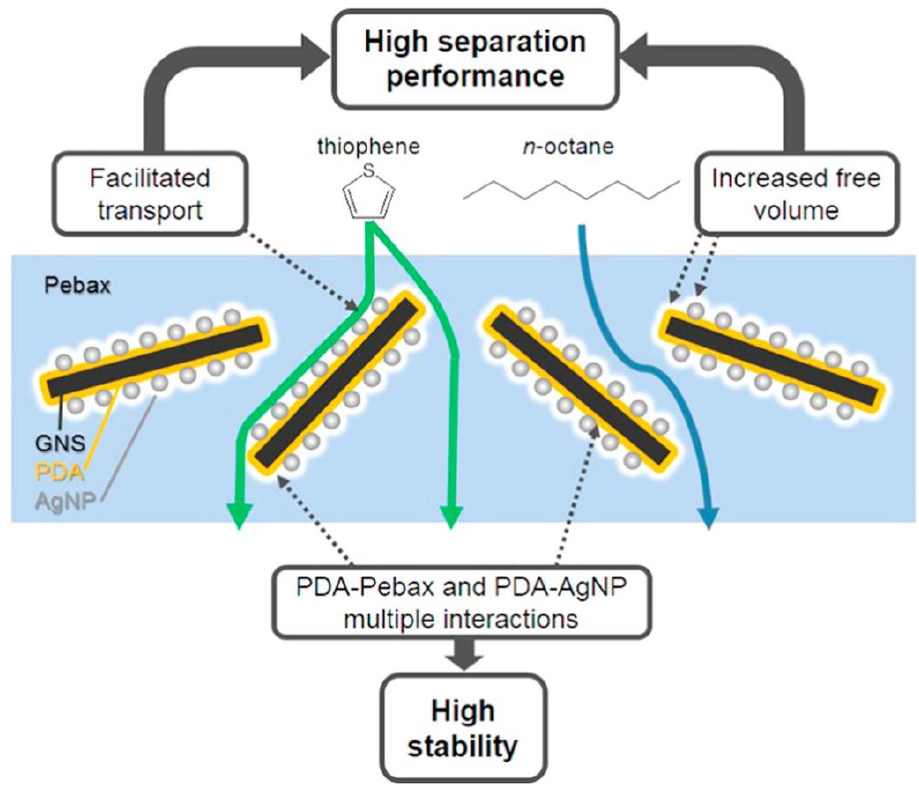
Figure 4. Scheme of an MMM comprising graphene nanosheets (GNS) functionalized by polydopamine (PDA) coating and then loaded with silver nanoparticles (AgNP) (from ref. [35]). Graphene oxide (GO) is usually synthesised by chemical oxidation and exfoliation of graphite, (e.g., via the Hummers method) [85]. Contrary to graphene, GO is highly hydrophilic since the oxidation generates several oxygen-containing groups (hydroxyl, epoxide and carboxylic groups) on the GO surface. Among the revised papers, the only hydrophilic separation, namely IPA dehydration, was studied using PV membranes produced by inserting GO in both the selective hydrophilic layer and the porous hydrophobic support [36]. GO, embedded in the Pebax 1657 selective hydrophilic layer and in the PSf substrate, creates a mutual bridge between the two membrane layers. Accordingly, water molecules, selectively absorbed at the dense selective surface, can diffuse through to the porous support via GO polar groups. A permeate stream without IPA traces was achieved using only 0.4 wt% of GO in the membranes.